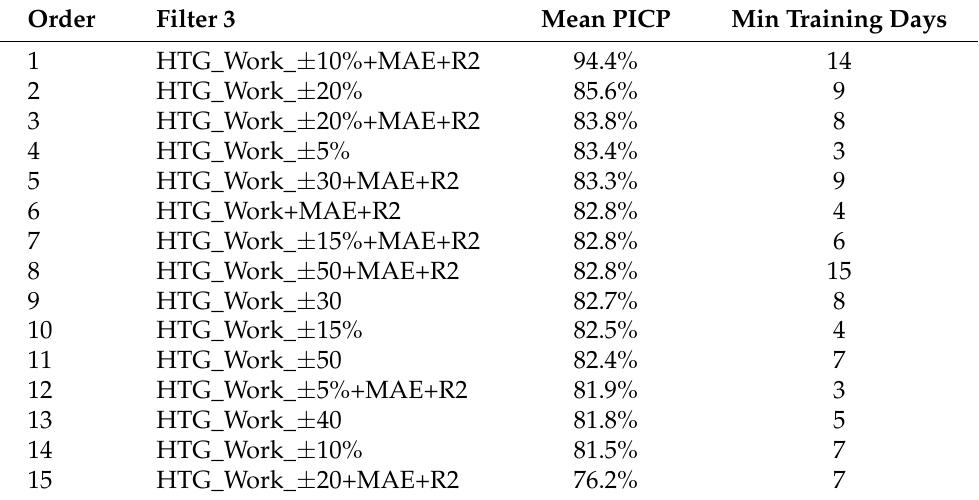
Table 4. Ordering of the characterization criteria for the heating working days employed in the